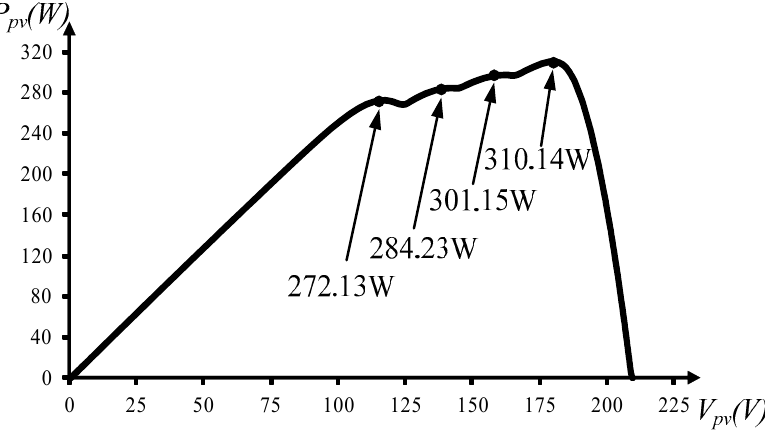
Figure 11. Output P–V curve of Case 3 photovoltaic module array.